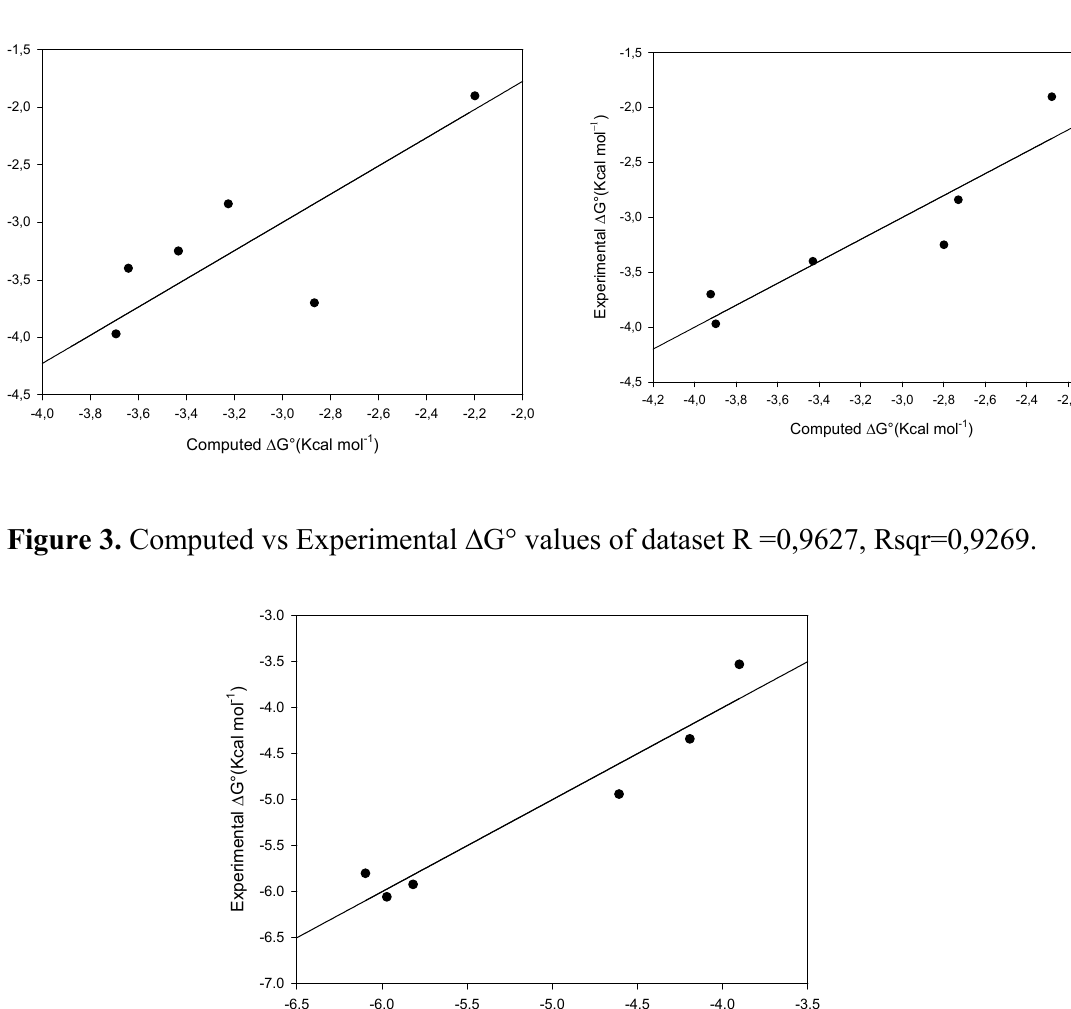
Figure 2 . (a) Computed vs Experimental Δ G° values of CSD complexes R = 0,7699, Rsqr=0,5927 (b) Computed vs Experimental Δ G° values of CSD complexes after docking R=0,9200, Rsqr=0,8465.